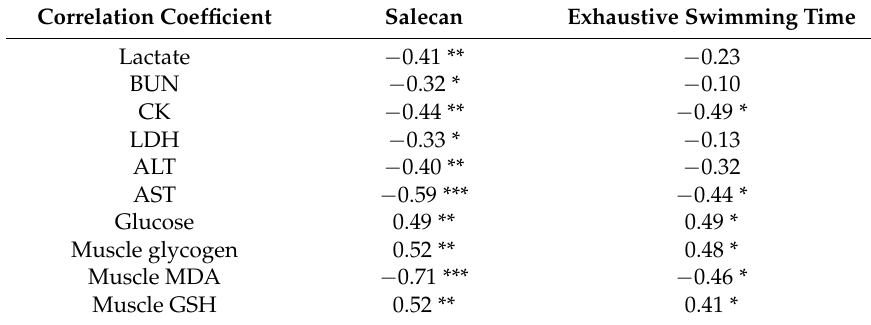
Table 1. Correlation analyses between each biochemical parameter and Salecan or exhaustive swimming time were performed. BUN—blood urea nitrogen; CK—creatinine kinase; LDH; ALT—alanine transaminase; AST—aspartate transaminase; MDA—malondialdehyde; GSH—glutathione.